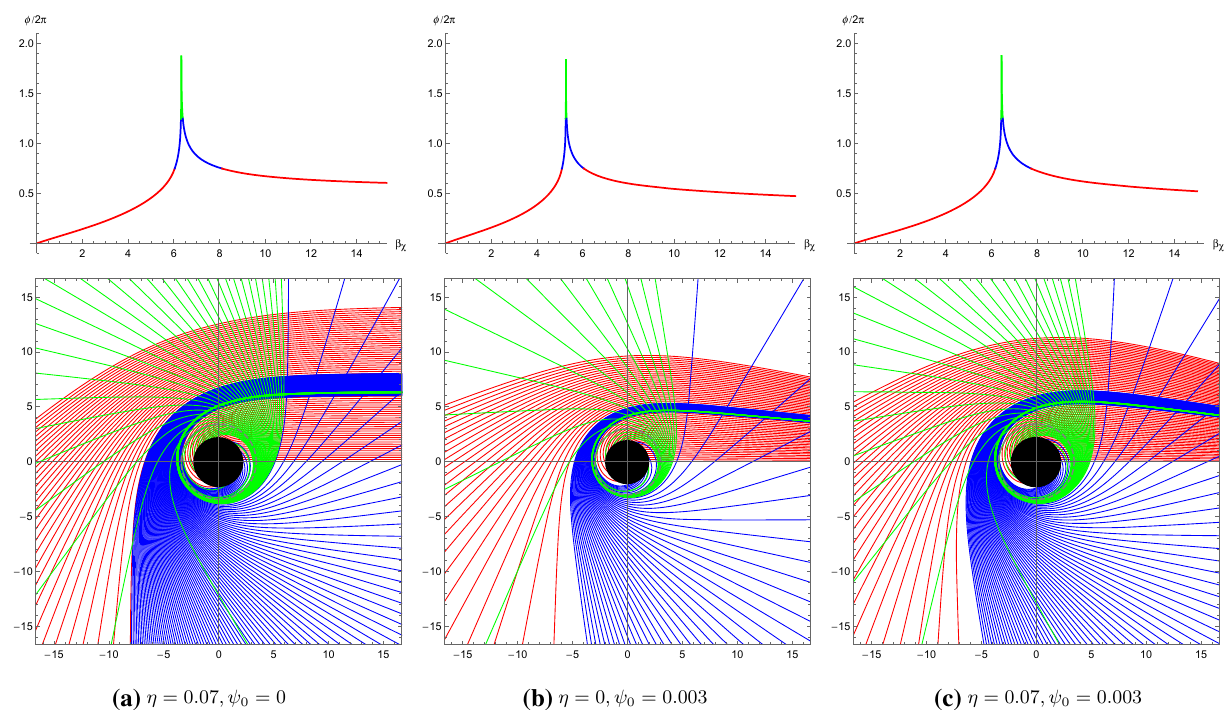
(b) η = 0 ,ψ 0 = 0 . 003 (c) η = 0 . 07 ,ψ 0 = 0 . 003 Fig. 3 Behavior of photons in the f ( R ) global monopole black hole as a function of the impact parameter b c